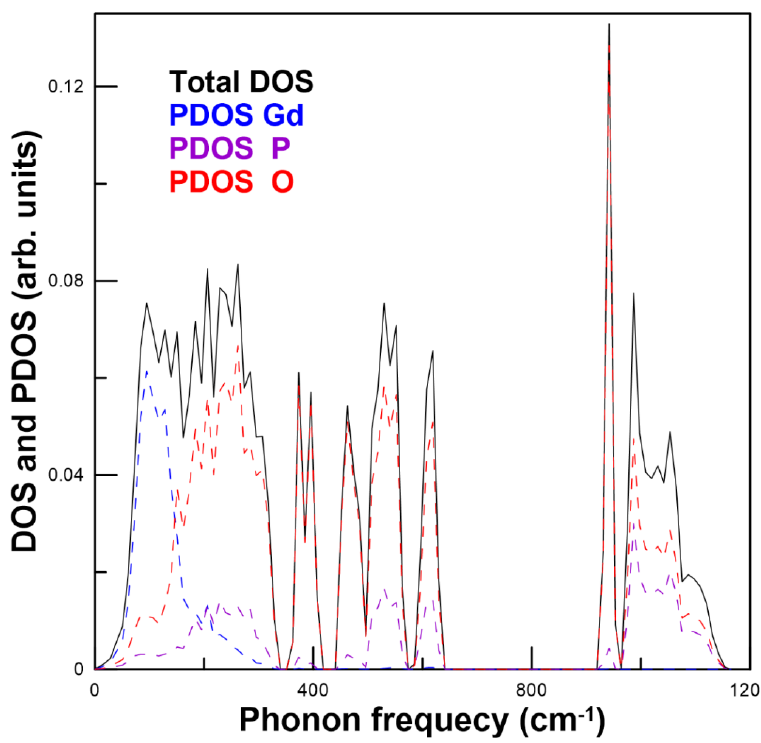
Figure 9. (Color online) Partial and total phonon density of monazite-type GdPO 4 states. Figure 9. ( Color online ) Partial and total phonon density of monazite-type GdPO 4